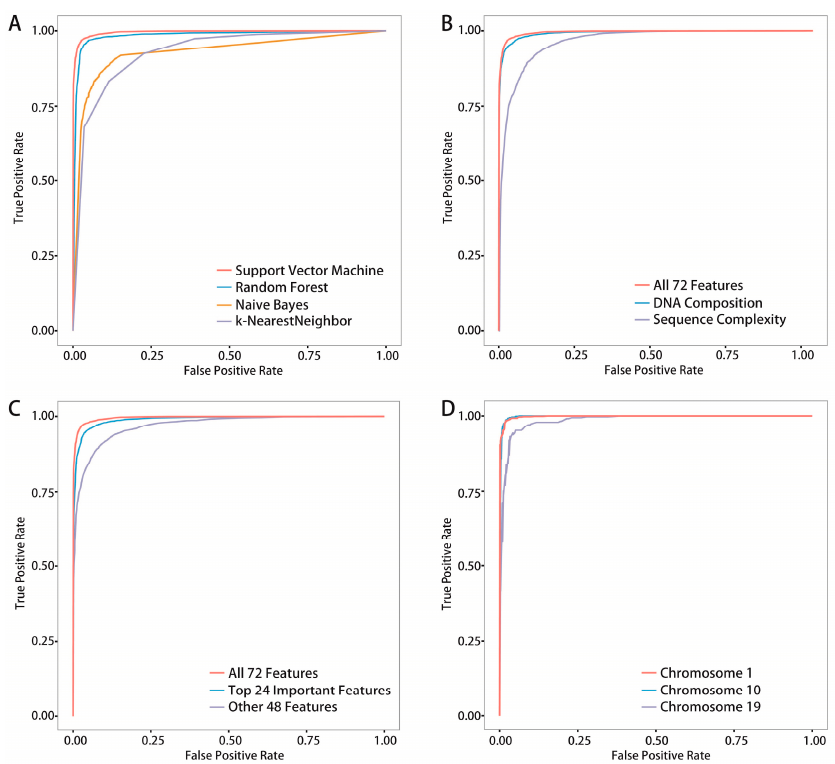
Figure 2. Receive Operating Characteristic (ROC) curves of different comparisons: ( A ) ROC curves of comparisons between two groups of features using 10-fold cross-validation; ( B ) ROC curves of comparisons between the top 24 important features and remaining 48 features using independent testing; ( C ) ROC curves of comparisons between four common classifiers using independent testing; and ( D ) ROC curves of three mouse chromosome predictions.